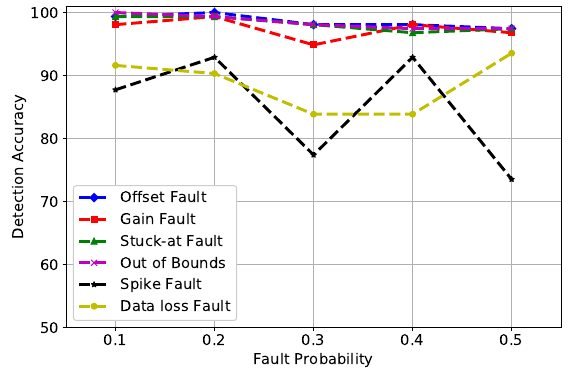
Figure 7. RF detection accuracy of fault types.